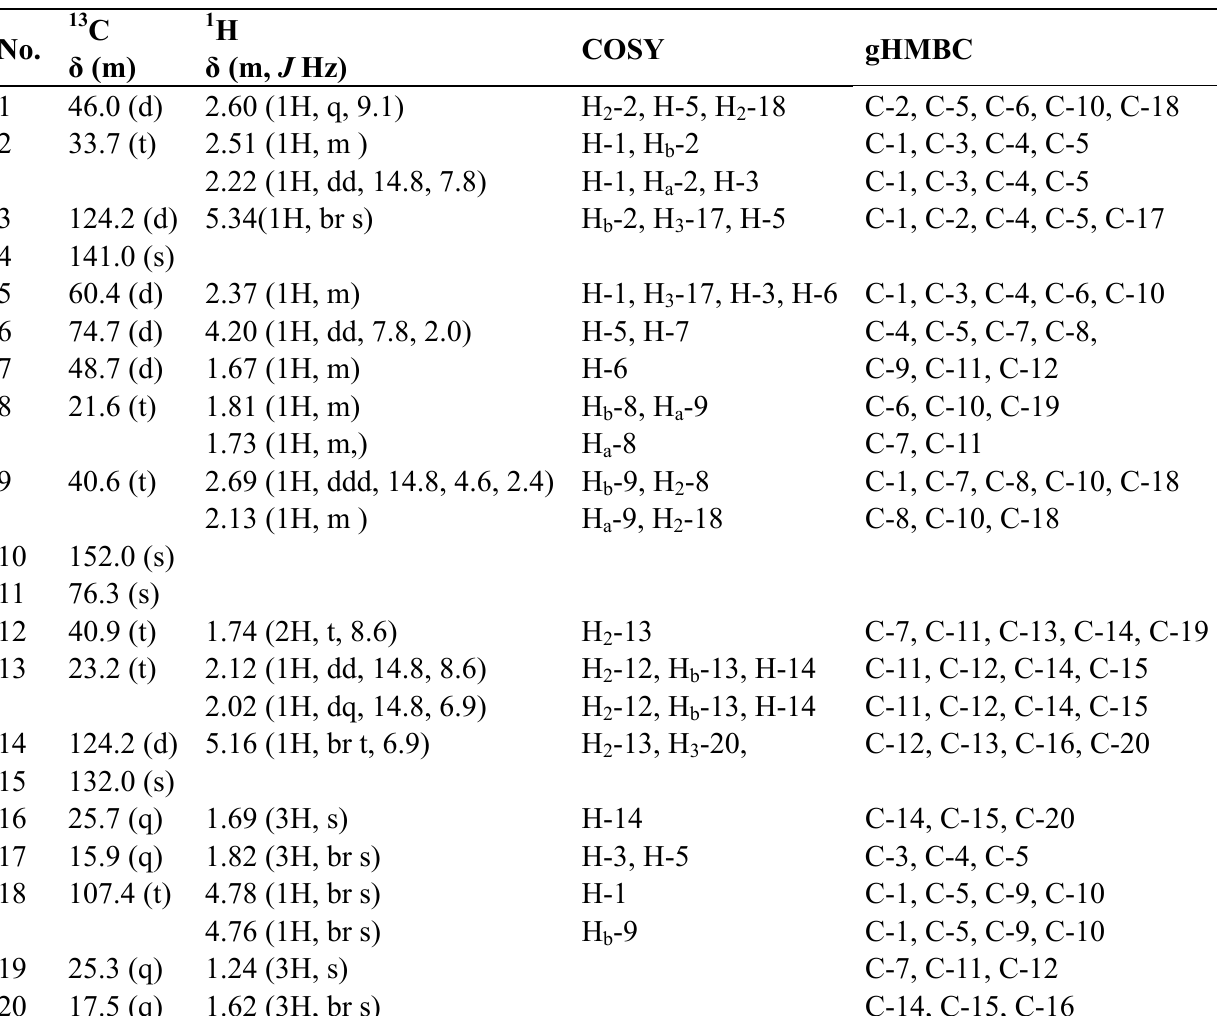
) for dictyol E ( 2 3